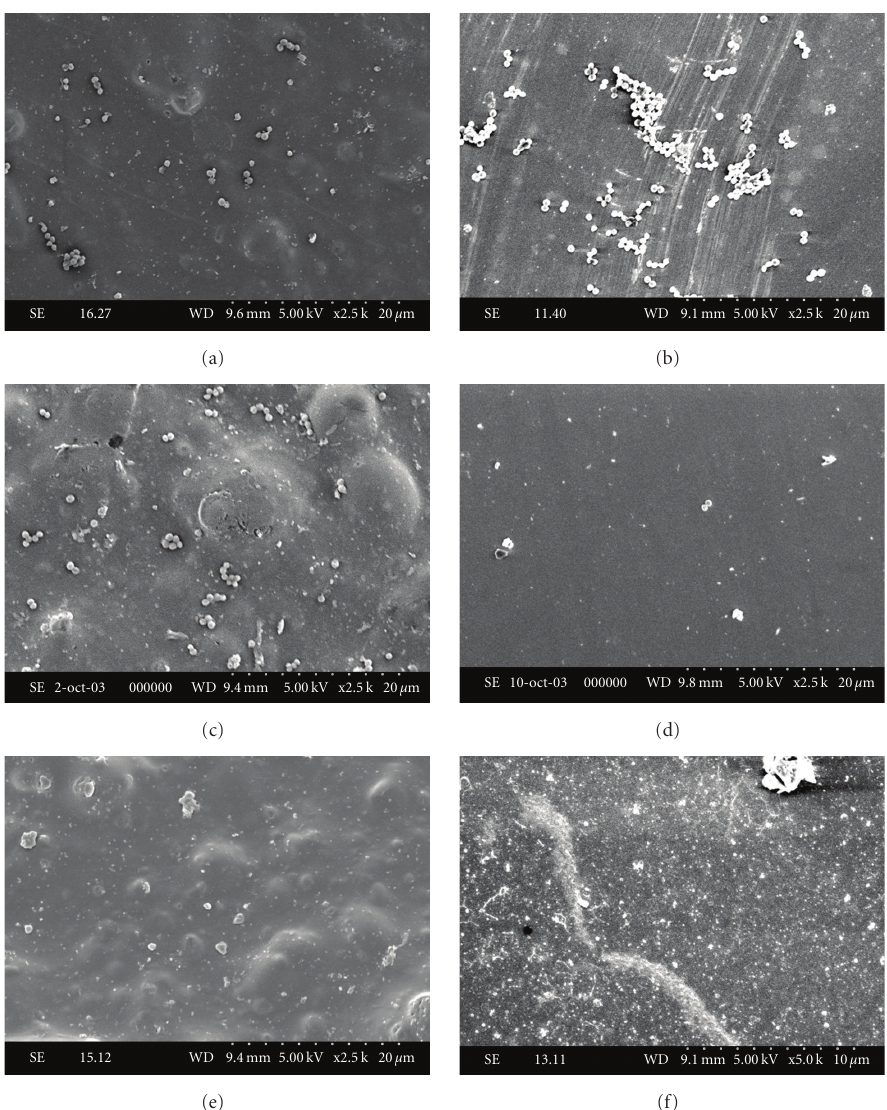
Figure 4: Attachment (at di ff erent pH levels) of Staphylococcus aureus to polystyrene ((a), (c), and (e)) and to glass ((b), (d), and (f)) at pH 6 ((a) and (b)), pH 7 ((c) and (d)), and pH 8 ((e) and